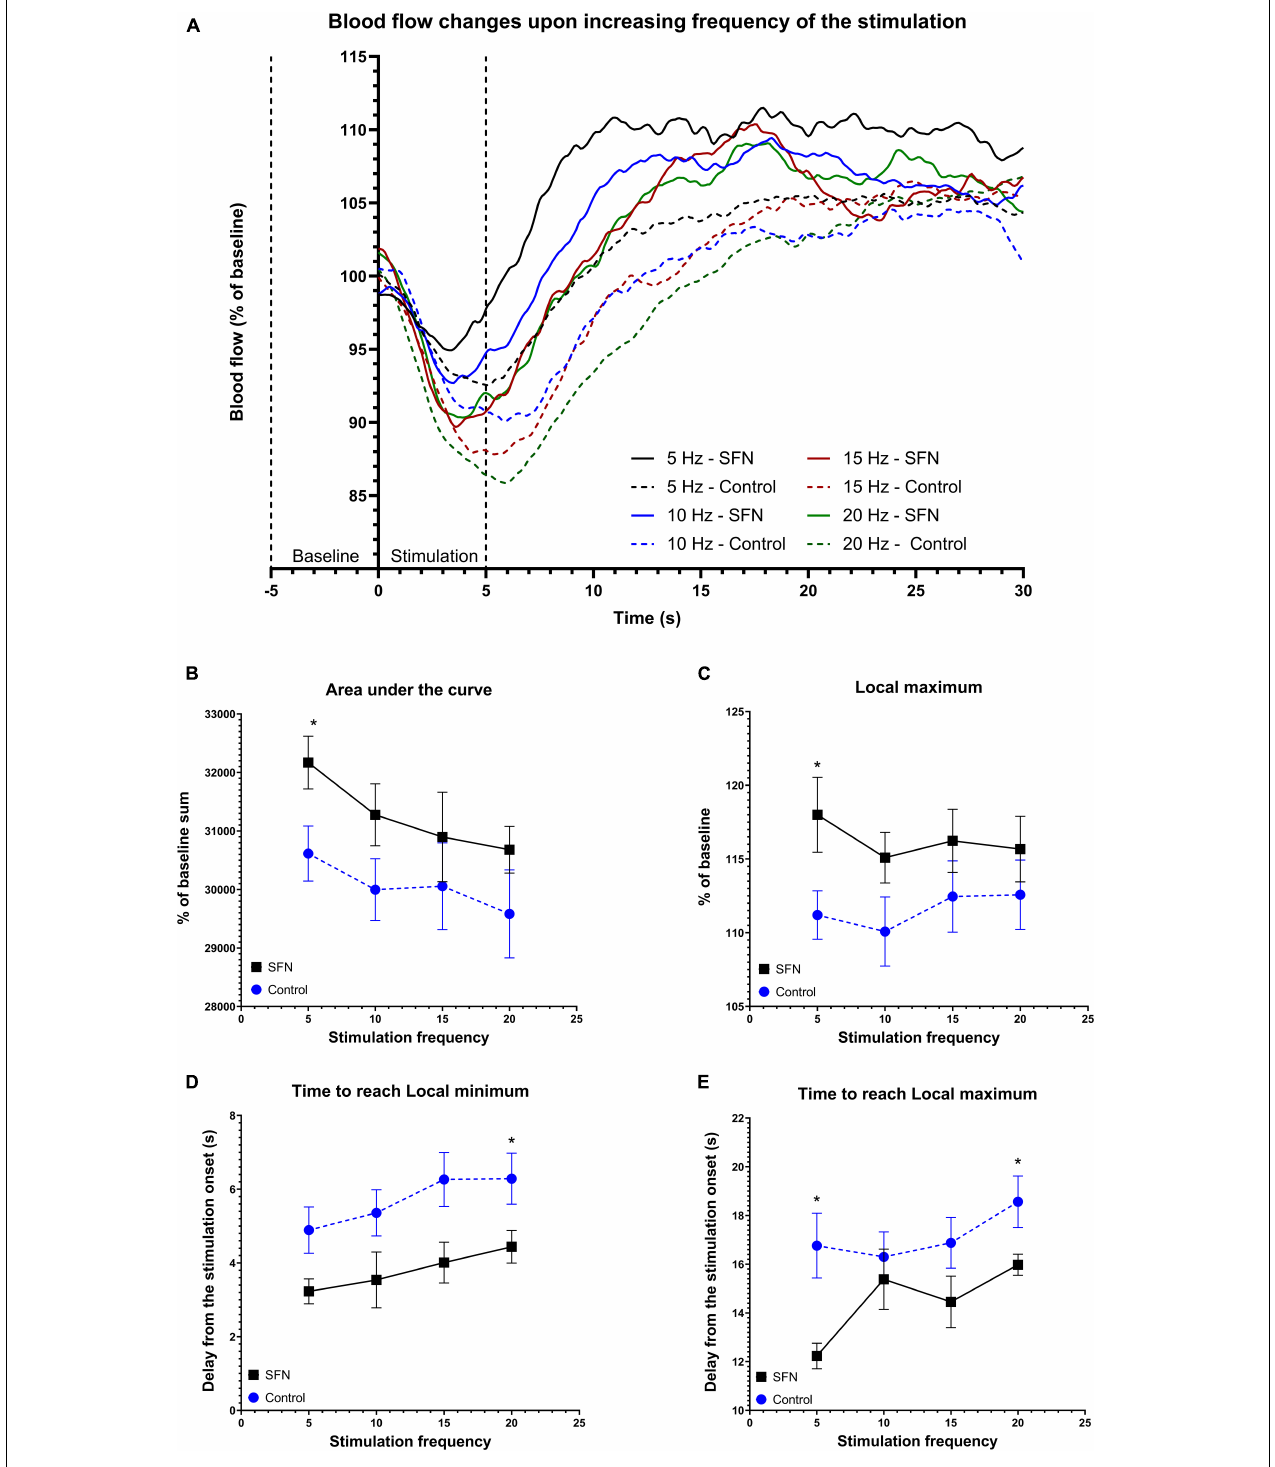
FIGURE 7 | SFN pretreatment improved blood flow and accelerated response to the electrical stimulation of increasing frequency. Baseline was calculated as average of values from 5 s before the stimulation to its onset. The average value at any given time (smoothed line) for each frequency and group is shown panel (A) . Dotted lines denote the beginning of baseline measurement and end of stimulation. Parameters that had shown SFN as a significant factor on two-way ANOVA are shown panels (B–E) . We observe increased AUC (B) suggesting increased total blood flow during the 30 s period, increased L max (C) , and quicker response as shown when comparing both time to reach L min (D) and L max (E) . Multiple unpaired t -tests were run to compare values at each frequency, significant results are denoted by an asterisk. All values (B–E) are reported as mean ± SEM (* P < 0.05).